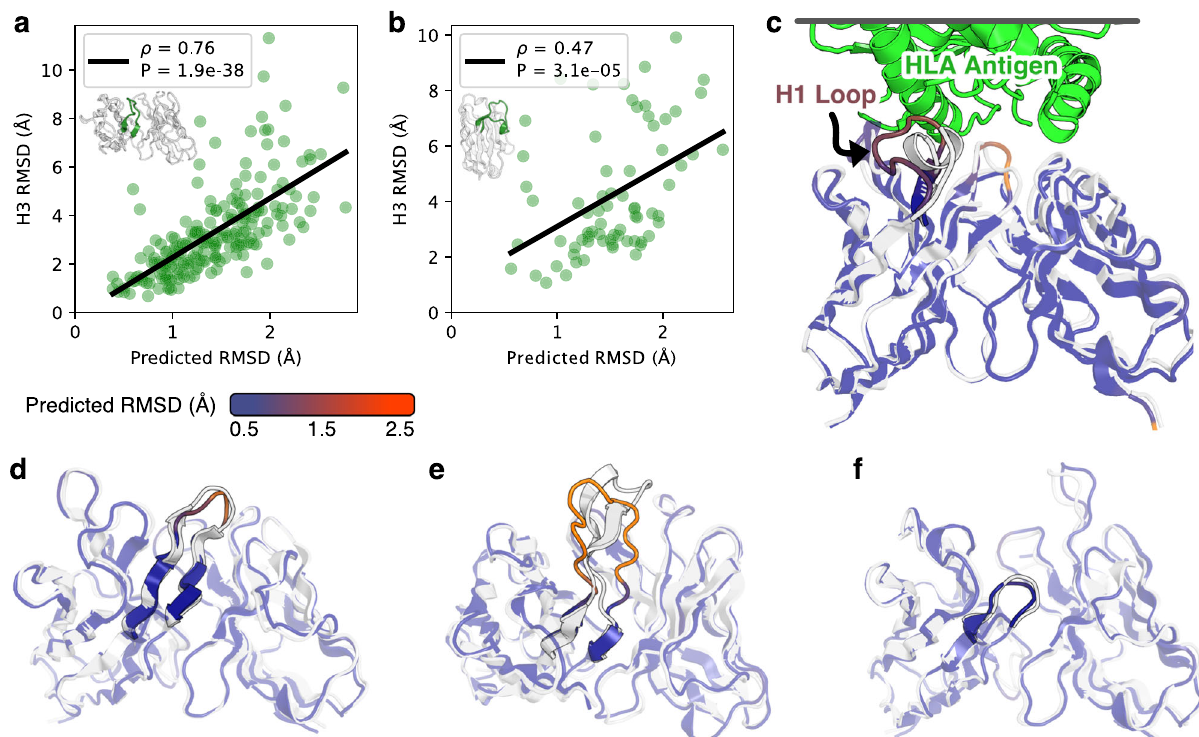
Fig. 3 | Errorestimation for predicted antibody structures. Reported Spearman correlationcoef fi cients( ρ )arebetweenpredictedandcalculatedRMSDvalueswith associated p values calculated according to a two-sided t -test. Source data are provided as a Source Data fi le. a Comparison of CDR H3 loop RMSD to predicted error for paired antibody structure benchmark. Gray space represents cumulative average RMSD of predicted CDR H3 loops from native structure. b Comparison of CDR3 loop RMSD to predicted error for nanobody structure benchmark. Gray